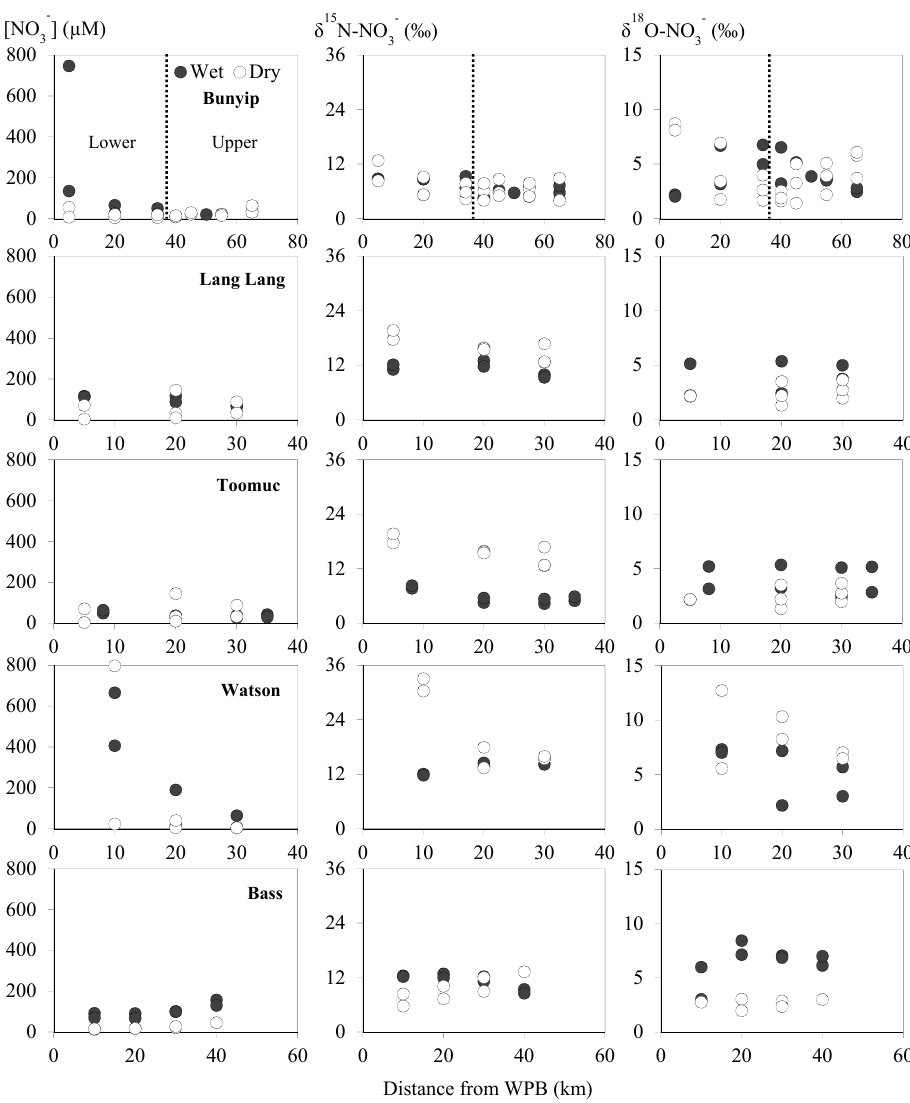
Figure 3. Spatial and temporal variations of nitrate concentrations and isotope values. Closed circles represent data obtained during the wet periods. Open circles represent data obtained during the dry